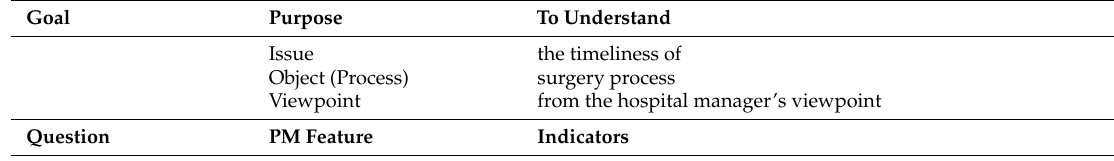
Table 4. GQFI Table for Surgery